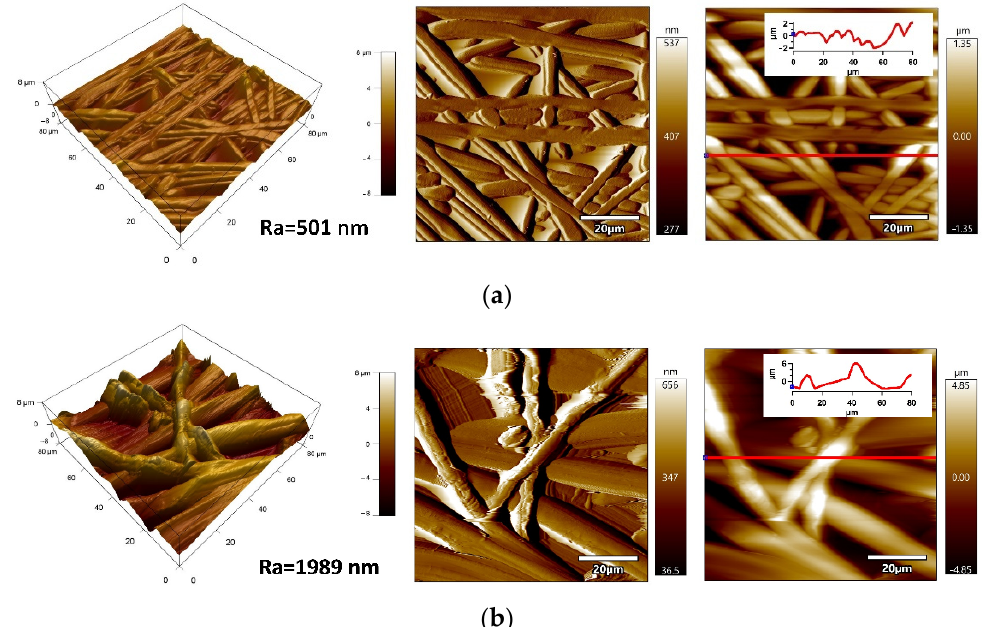
Figure 3. AFM images (from left to right: 3D heighta Amplitude, ZSensor with line profile) of: ( a ) neat PS and ( b ) PS/PDMS 1:1:10 (g/g/mL) on Al substrate.